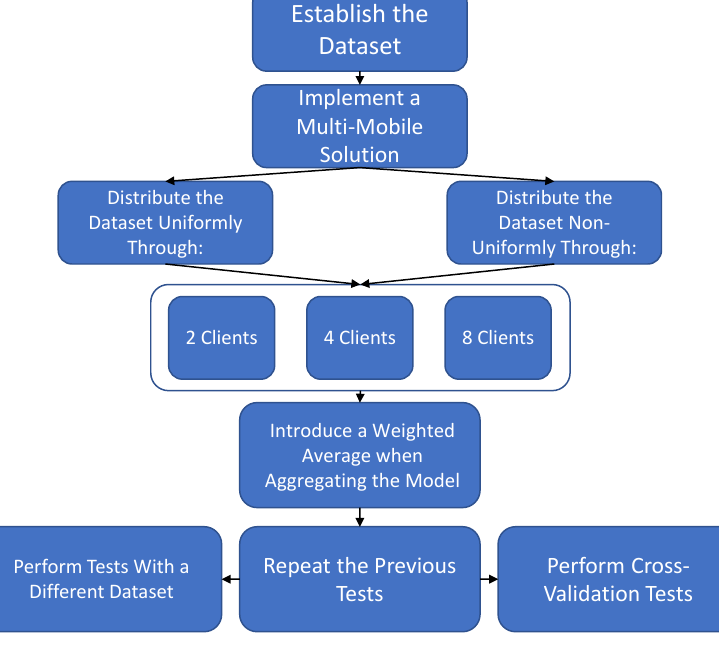
Figure 5. Experimental